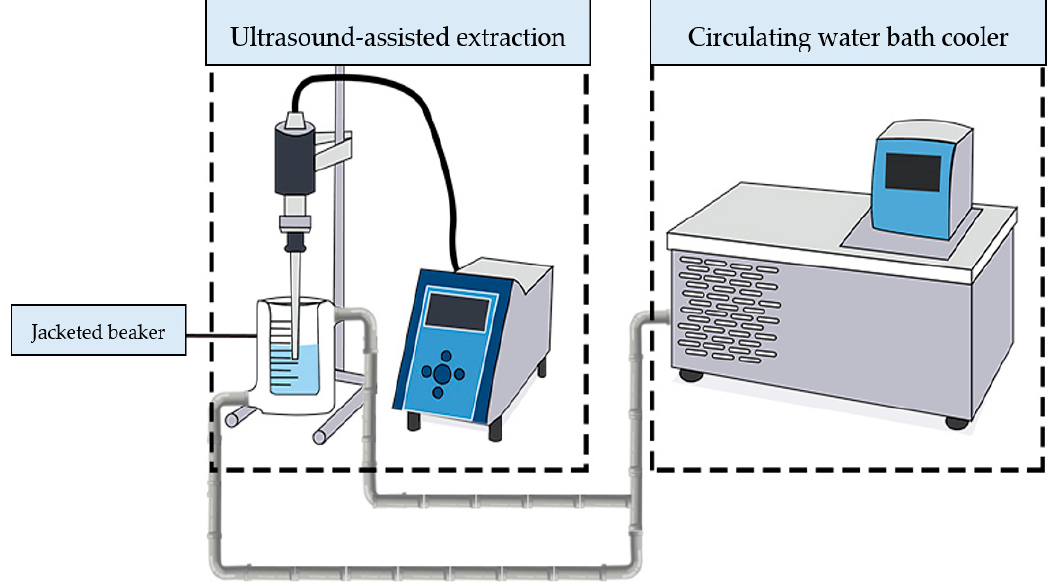
Figure 1. Schematic of extraction system using UAE coupled with circuit water bath cooler